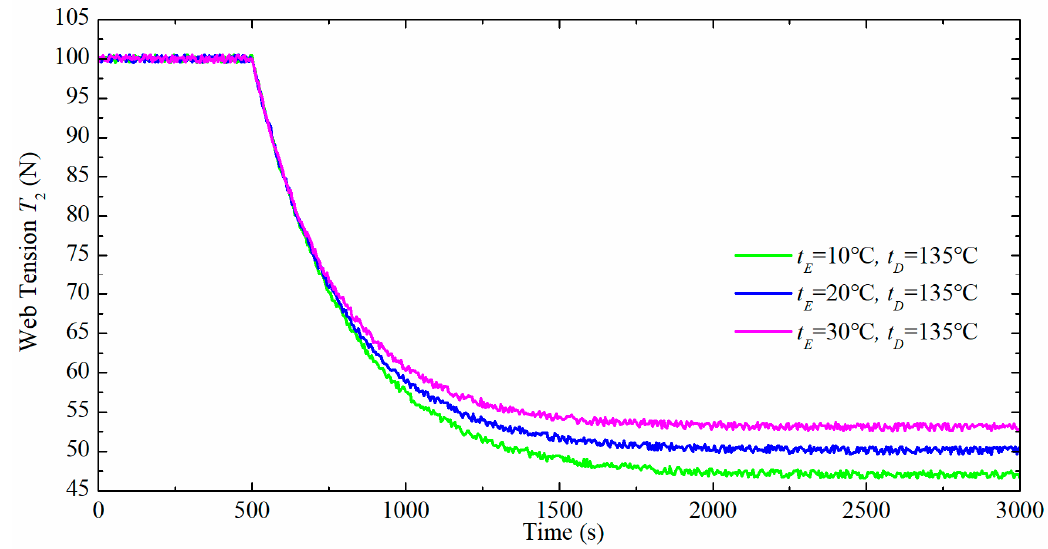
( ) T t as ( ) v t has step changes at different room 2 1